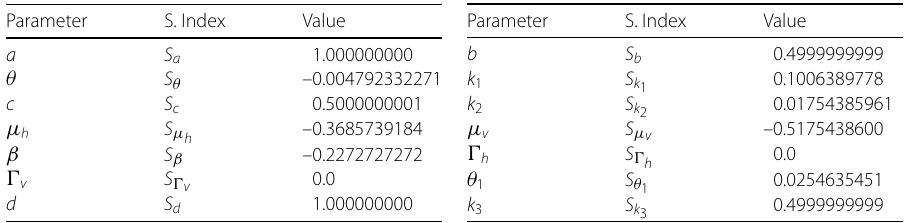
Table 1 Sensitivity indices of the reproduction number R 0 against mentioned parameters Parameter S. Index